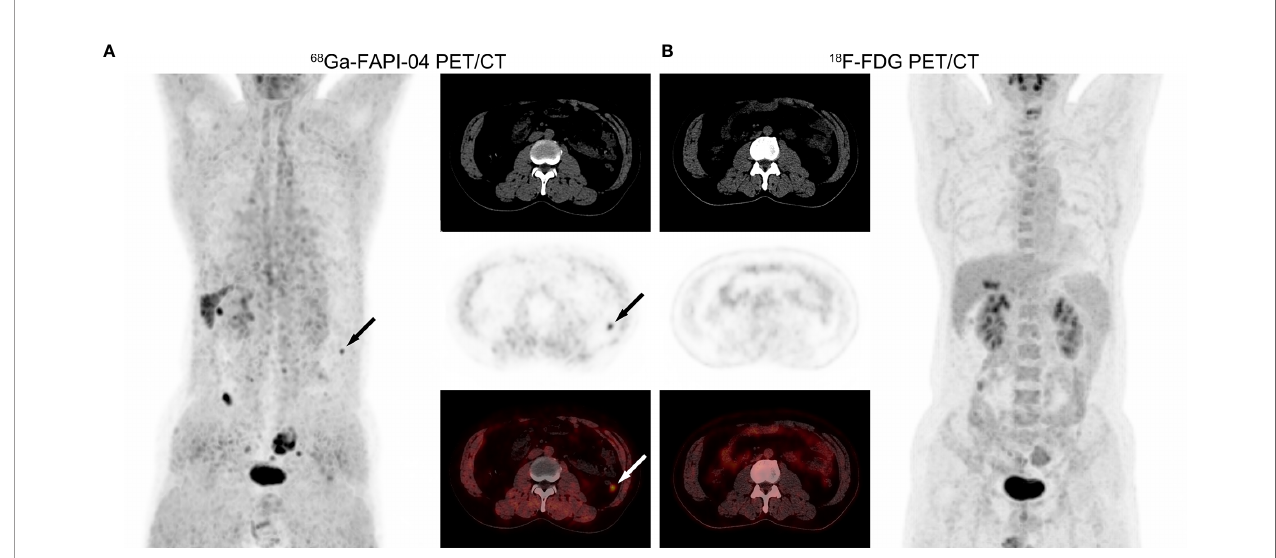
FIGURE 4 | PET/CT images in a 51-year-old male patient with poorly-differentiated HCC and regional lymph node metastasis. (A) 68 Ga-FAPI-04 PET/CT revealed a strongly FAPI-avid lesion (black and white arrows, SUV max = 6.67, TBR = 15.2) that was pathologically con fi rmed as lymph node metastasis of the porta hepatis. (B) 18 F-FDG PET/CT showed no elevated uptake of this extrahepatic metastasis (SUV max = 2.84, TBR =